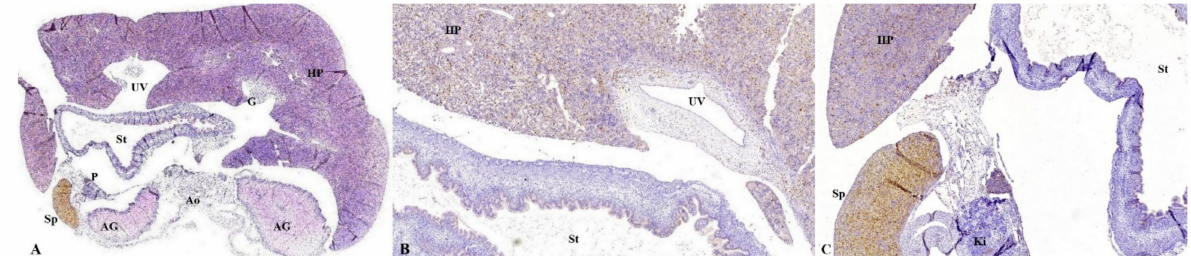
Figure 9. Transverse section at the level of the abdomen. ( A ): The hepatic parenchyma (HP) located anteriorly, the disorganized hepatocyte cords, with the presence of Kuffer cells among the hepatocyte cords, the stomach (St) with macrophages in the gastric wall, the posterior adrenal glands (AG) and the spleen (Sp), intensely immunolabeled with anti-CD68, which demonstrates the increased number of the macrophages present in the tissue structure. Immunohistochemical staining with anti-CD68 antibody; ( B ): the hepatic parenchyma (HP) located anteriorly, the disorganized hepatocyte cords, with the presence of Kuffer cells among the hepatocyte cords, the stomach (St) with macrophages in the gastric wall; ( C ): the hepatic parenchyma (HP) anteriorly, disorganized hepatocyte cords, with the presence of Kuffer cells among the hepatocyte cords, the stomach with macrophages in the gastric wall, the posterior kidney (Ki) located posteriorly and the spleen (Sp) on the left, intensely immunolabeled with anti-CD68, which demonstrates increased number of macrophages present in the tissue structure. Immunohistochemical staining with anti-CD68 antibody. CD: Cluster of differentiation, HP: hepatic parenchyma, UV: umbilical vein, G: gallbladder, P: pancreas, St: stomach, AG: adrenal glands, Ao: Aorta, Sp: spleen, Ki: